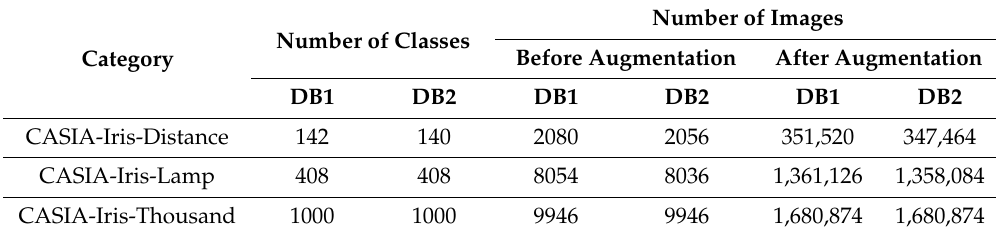
Table 3. Detail descriptions of experimental databases.